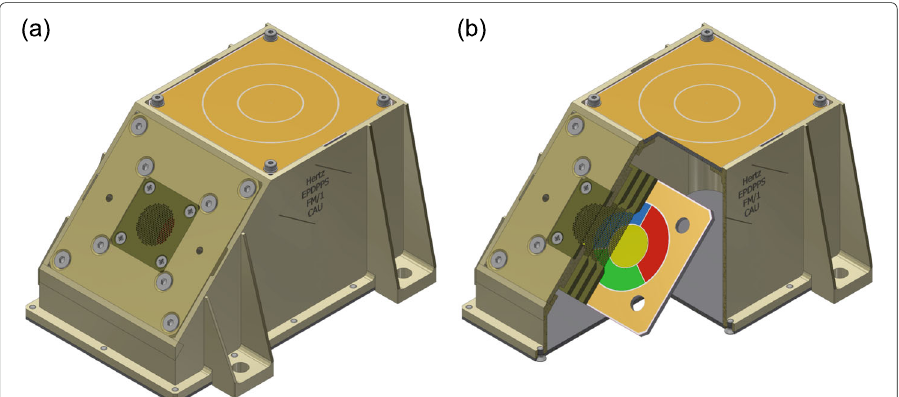
Fig. 3 The plasma sensor of the EPDP. (a) The entrance grid of the retarding potential analyzer is in the slanted face, and the plane Langmuir probe with guard ring is on the top face. (b) The view into the sensor shows the four grids and the segmented collector. (The two lateral empty bores in the slanted face are for the red-tag covers used before